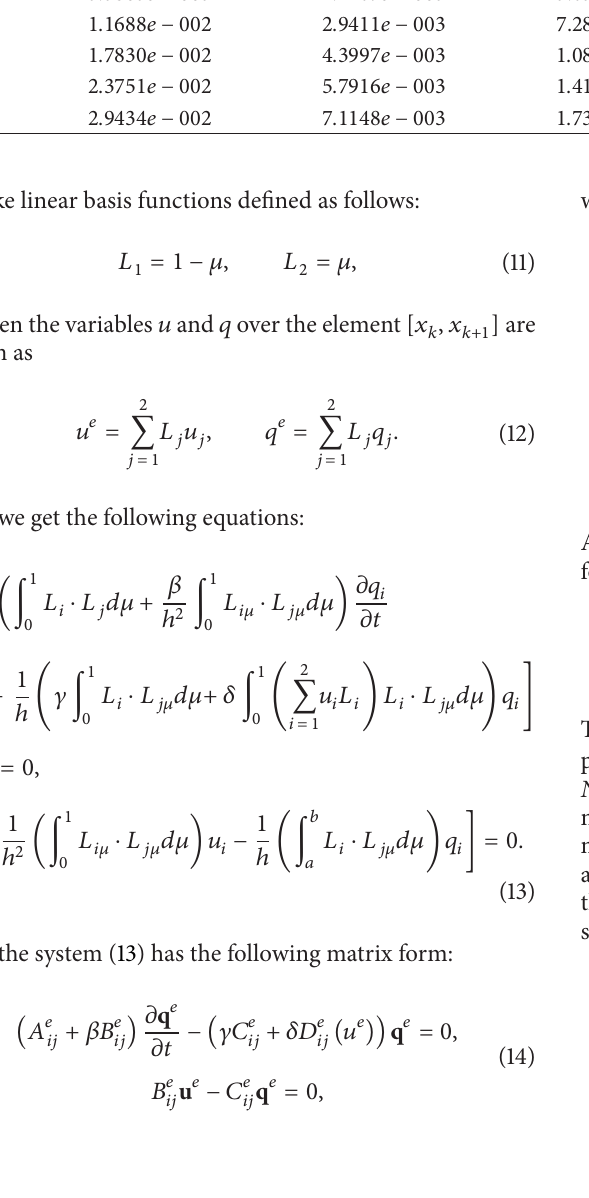
Table 2: Convergence order and error in 𝐿 2 norm for 𝑢 of time with ℎ = 0.125 and 𝑐 = 0.1 .